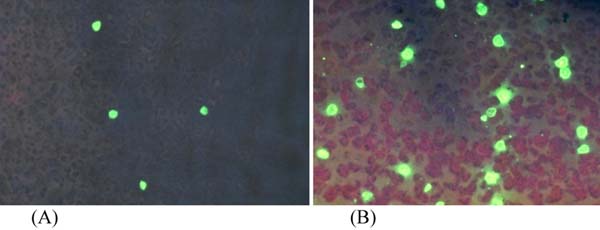
Pictures of iRBCs (magnification 400x) in thin smears. prepared from (A) 0.01% P. falciparum positive blood sample and (B) >1% P. falciparum positive sample, stained by direct IF reagent and visualized under x40 objective (400x magnification).